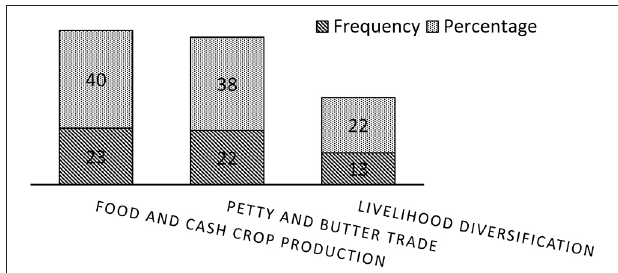
FIGURE 2 | Livelihood strategies of respondents (multiple response) n =